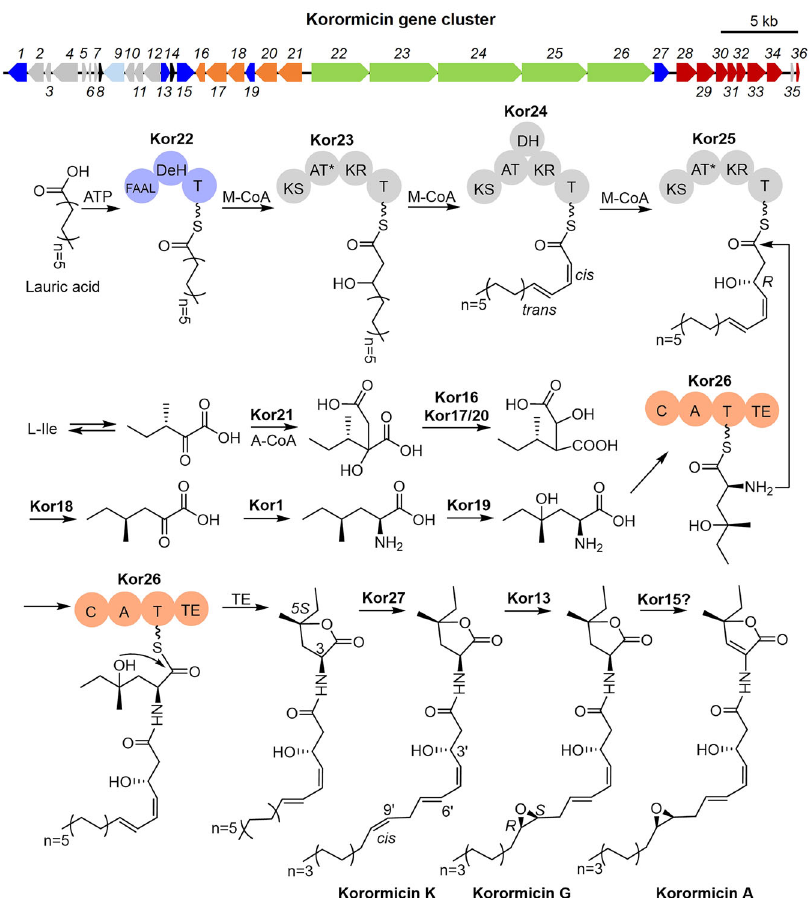
Fig. 2 The putative biosynthetic pathway of korormicins. The 52-kb kor gene cluster was identi fi ed from the genome of Pseudoalteromonas sp. McH1-7. The PKSs and NRPSs are shown in green, while the genes involved in the formation of the nonproteinogenic amino acid (2 S )-2-NH 2 -4-OH-4- methylhexanoate are in orange. Genes in the operon of NADH:ubiquinone reductase assembly (NQR) are presented in dark red, while those in dark blue may encode modi fi cation enzymes. Two transcriptional regulators are in black, and the rest are in gray. The proposed pathway is supported by the predicted functions of gene products in the identi fi ed kor gene